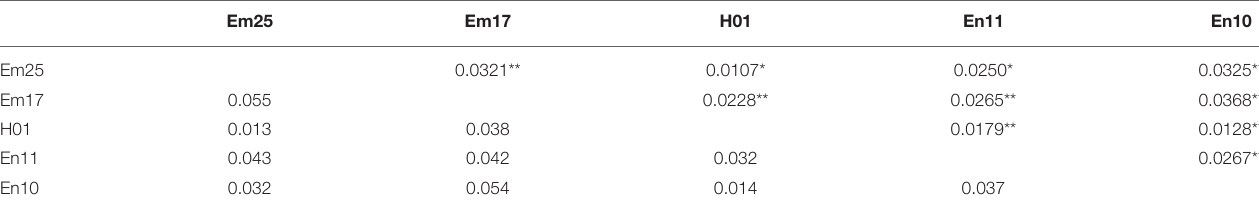
TABLE 4 | Pairwise F ST (above diagonal) and D ST (below diagonal) values along the transect, estimated by means of Weir and Cockerham methods 1984 and as the harmonic mean across loci, respectively (Weir and Cockerham, 1984).